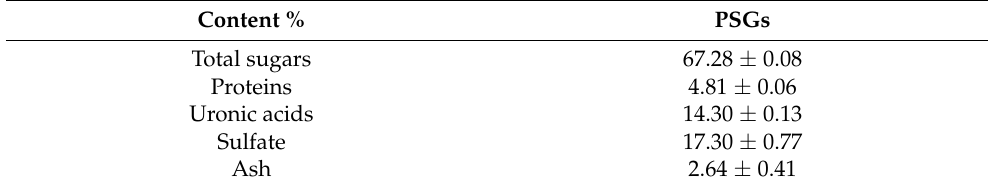
Table 1. The chemical composition of